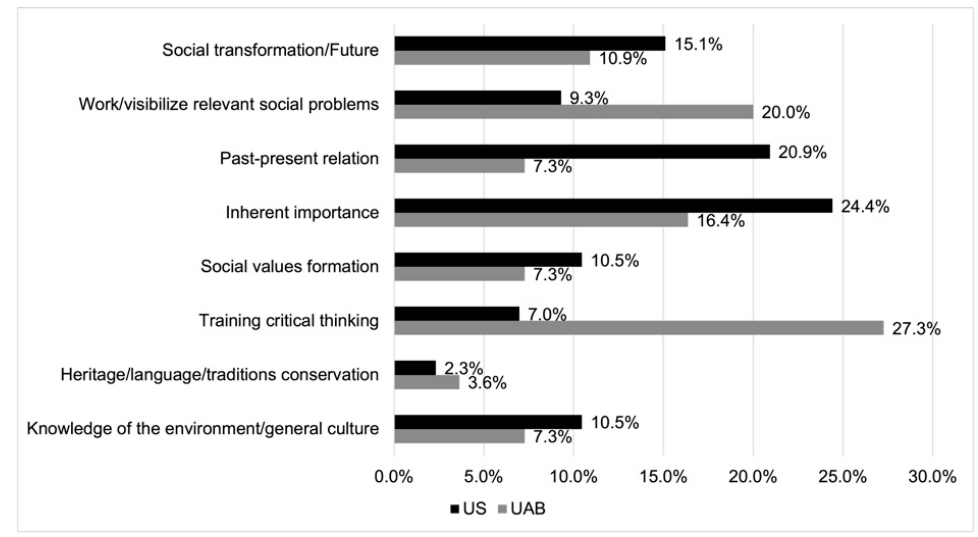
Figure 2. Purposes for working on identities in the classroom.